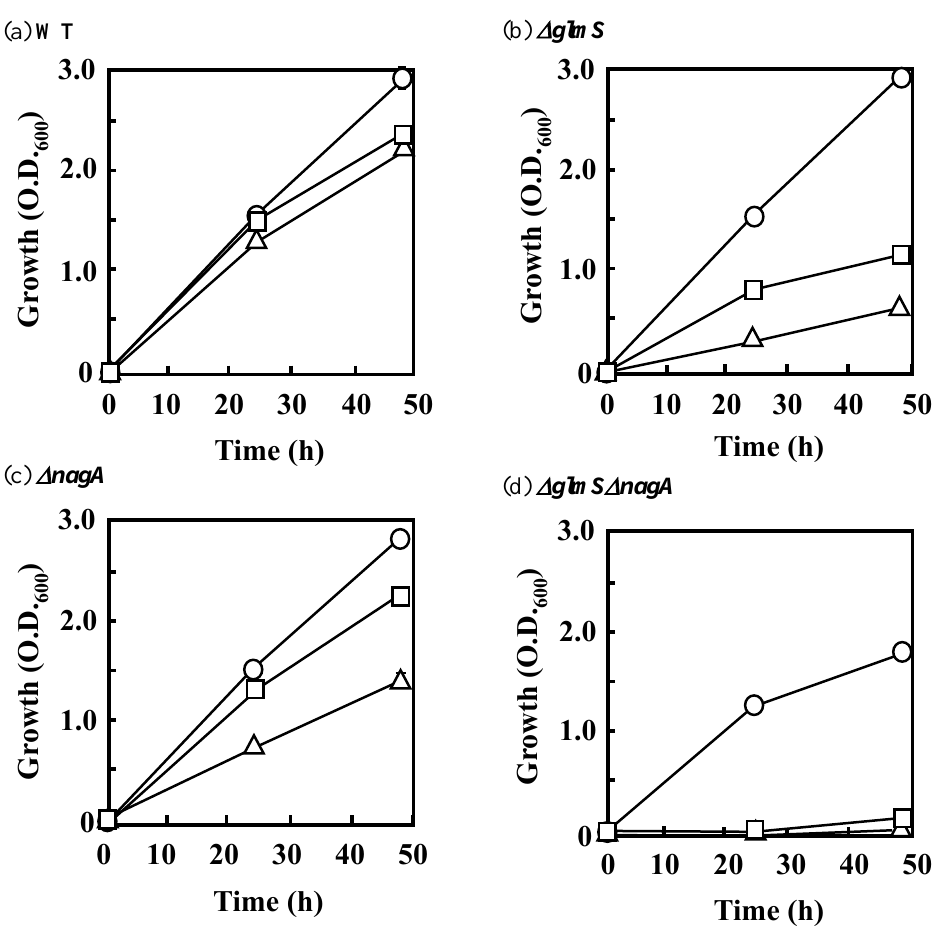
Figure 7. Growth of C. freundii IFO 13545 (wild type, WT) ( a ) and of its glmS , nagA , and glmSnagA disruptants ( Δ glmS ( b ); Δ nagA ( c ); and Δ glmS Δ nagA ( d )) in acetate medium containing 0.1 g·L −1 yeast extract (circles), in acetate medium lacking yeast extract (triangles), and in acetate medium lacking yeast extract and supplemented with 0.2 g·L −1 GlcNAc (squares). This experiment was performed in triplicate; the averages ± standard deviations of the values obtained are shown. Almost all the standard deviations were within the symbol sizes.